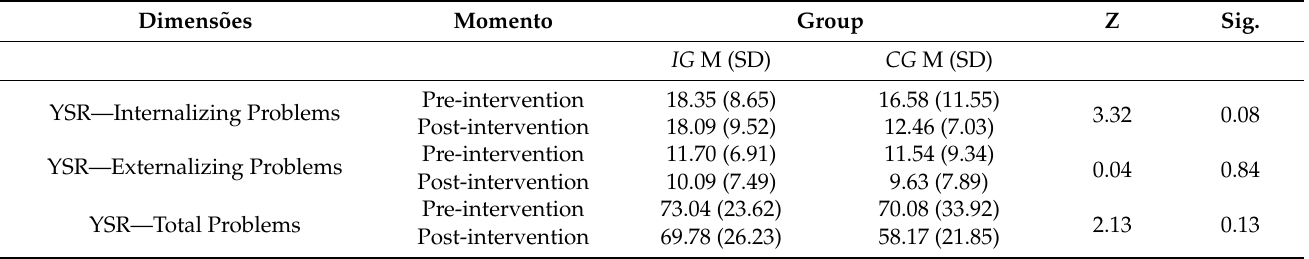
Table 2. Emotional and Behavioral Problems in IG and CG at pre-intervention and